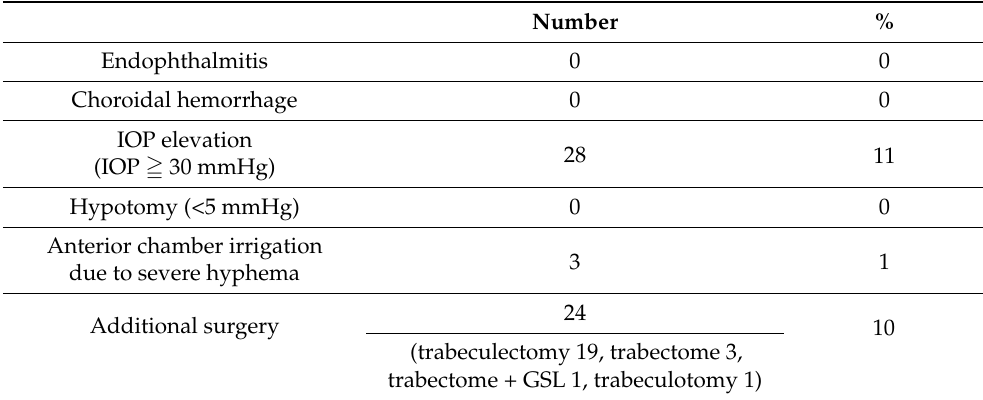
Table 2. Surgical complications and postoperative procedures.